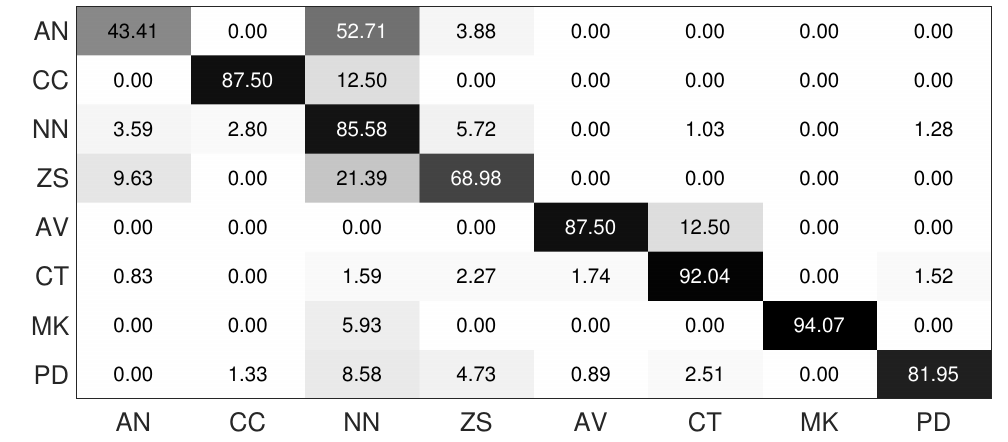
Figure 5. Confusion matrix of the first group of the LCF-15 image dataset.